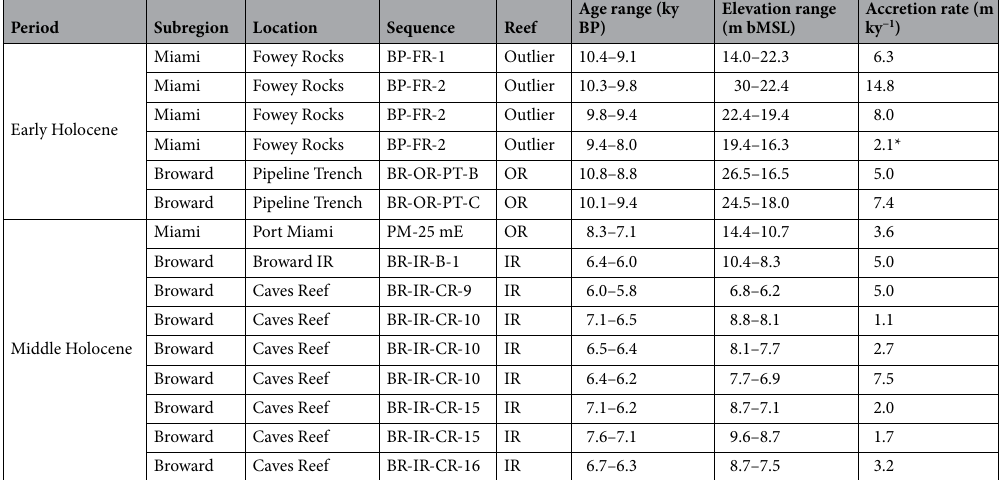
Table 1. Vertical accretion rates of Acropora palmata -dominated reefs on the Southeast Florida Continental Reef Tract. Accretion rates are reported in meters per thousand years (m ky −1 ) for dated reef sequences (OR = Outer Reef and IR = Inner Reef) during the Early and Middle Holocene (see “Methods” and Supplementary Discussion). Age ranges represent the lower and upper ages of each interval over which accretion rates were calculated. The ranges of elevations of samples used to calculate accretion are given in meters below modern mean sea level (m bMSL). The accretion rate indicated by an asterisk was not included in statistical analyses because the upper age of the sequence was not from A. palmata (see Supplementary